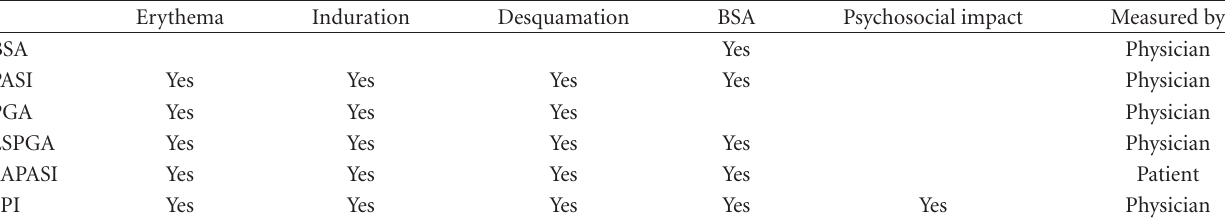
Table 1: Clinical assessment of psoriasis outcome